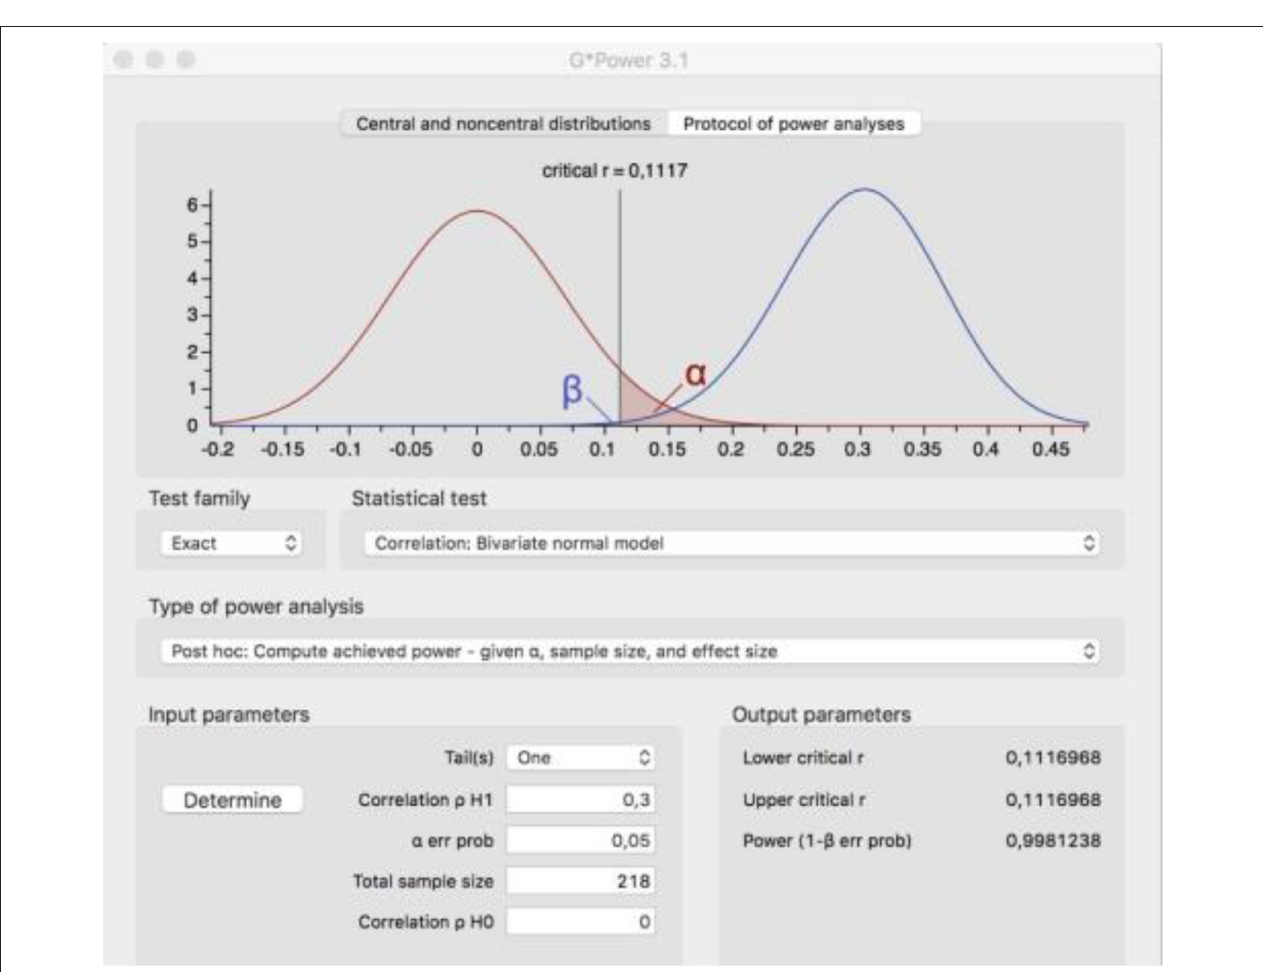
FIGURE 2 | Statistical power of the